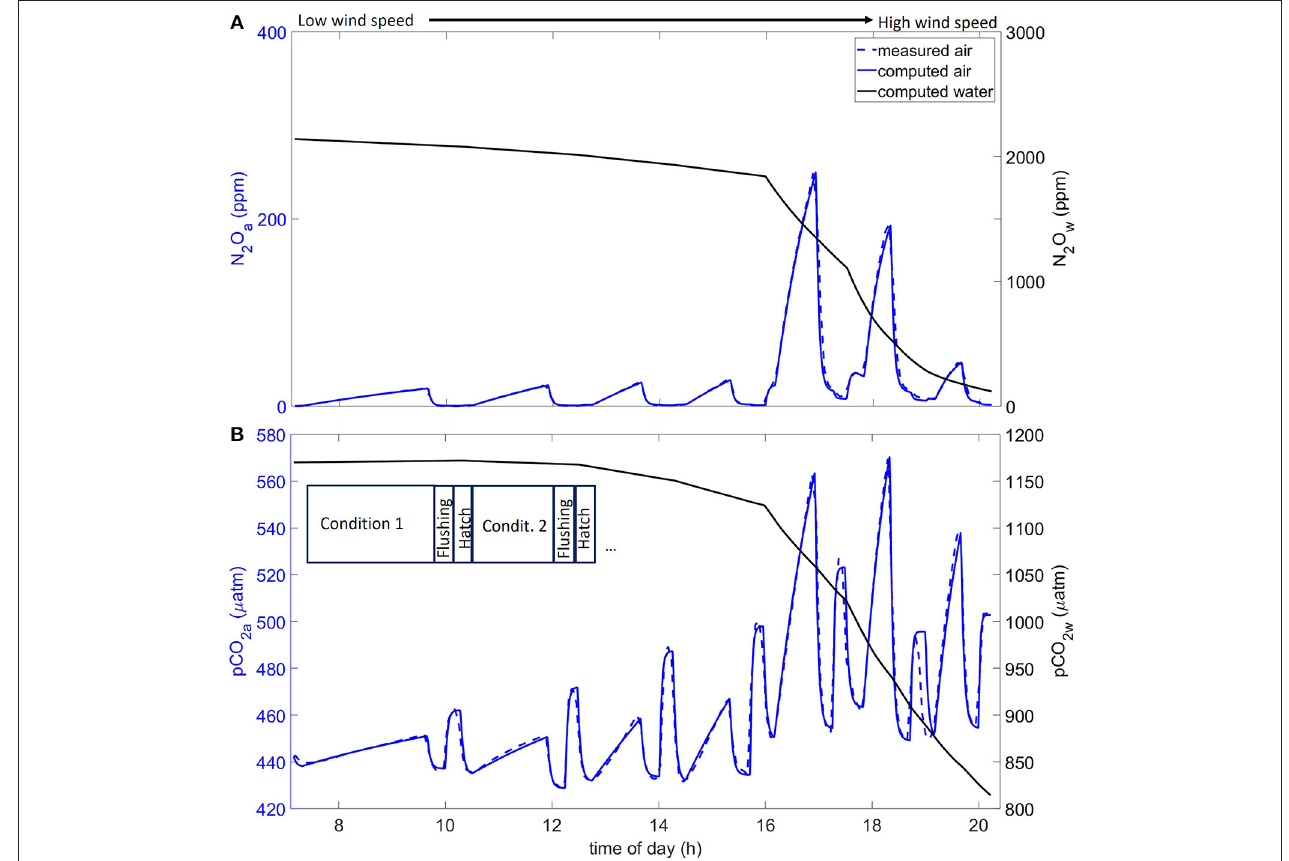
FIGURE 2 | Example of conditions with computed water (w) and computed and measured air (a) for various times of the day on November 19, 2014. (A) N 2 O; (B) p CO 2 . An example of sequences with stable wind speed condition, flushing time, and sampling time (when the hatches were opened) is shown in (B) . Wind speed increased from left to right, as show in the upper